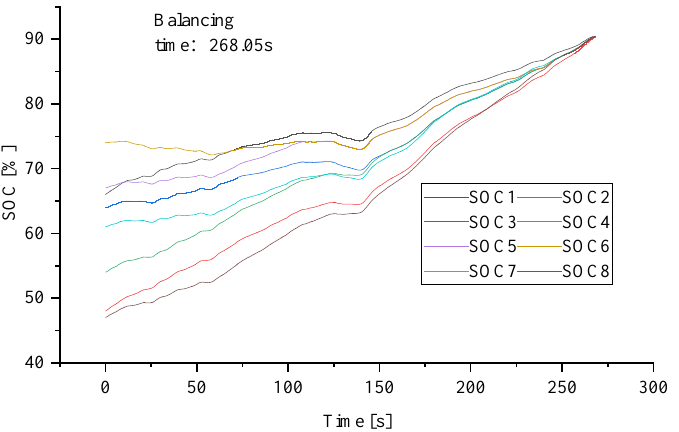
Figure 8. Lithium battery SOC change chart. (Multi-layer equalisation circuits and equalisation strategies in this